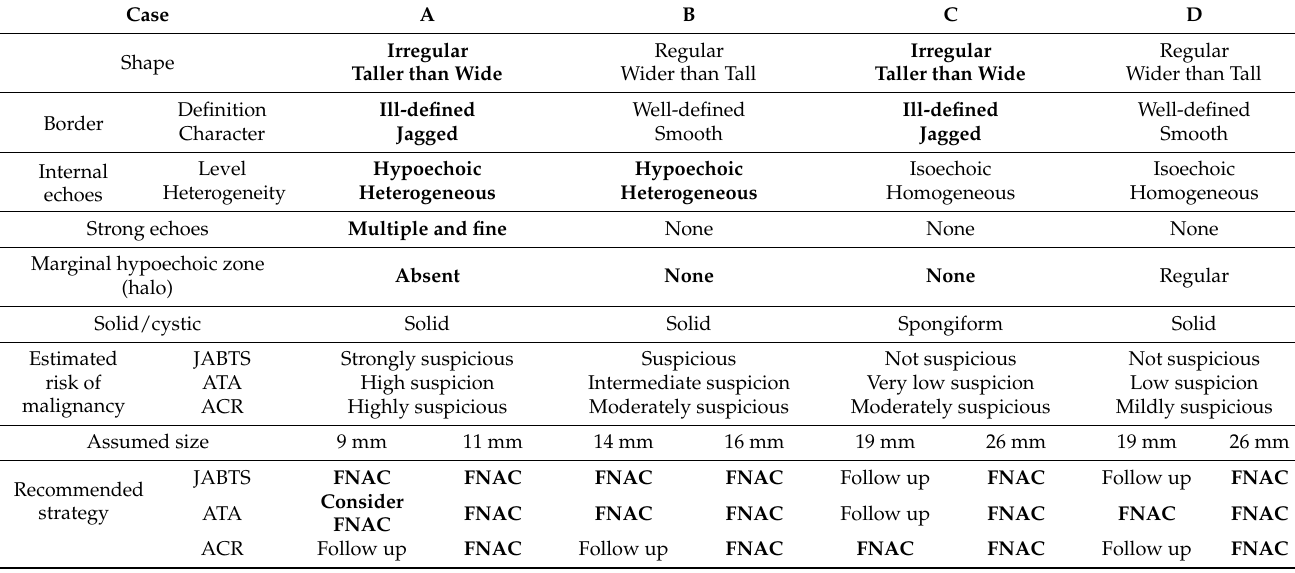
Figure 4. Sonographic images of Case ( A – D ) for case studies in Table 3. The left and right panels of each case show the transverse and longitudinal images, respectively. The taller-than-wide sign was evaluated using transverse images. Table 3. Comparison of FNAC guidelines with case studies. Malignant ultrasound findings and FNAC recommendations are presented in